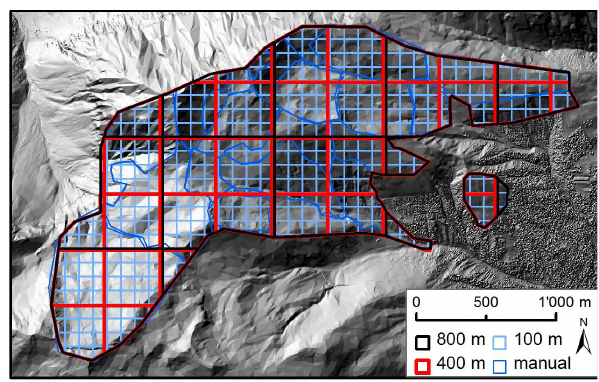
Fig. 4. Aggregation of sub-aras for the Wannengrat area by the man- ual and the automatic method (grids of different cell